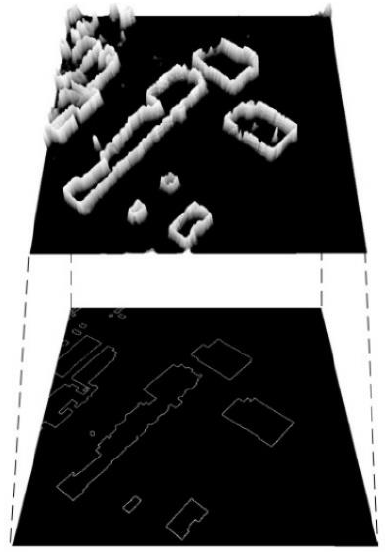
Figure 6. Diagram of edge refinement algorithm.